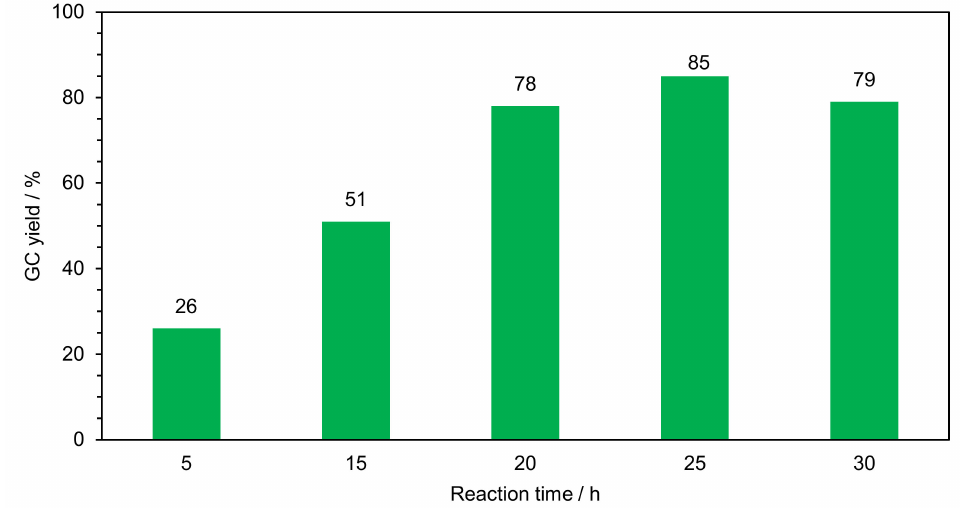
Figure 11. Effect of the reaction time on the product yield. Reaction conditions: 1,1-diphenylethylene (0.3 mmol); THF (1 mL); DTBP (4 equiv.); KI (20 mol%), Cu 1 Ce 0.7 Si catalyst (8.4 mg–4.8 mol%); 120 ◦ C; under